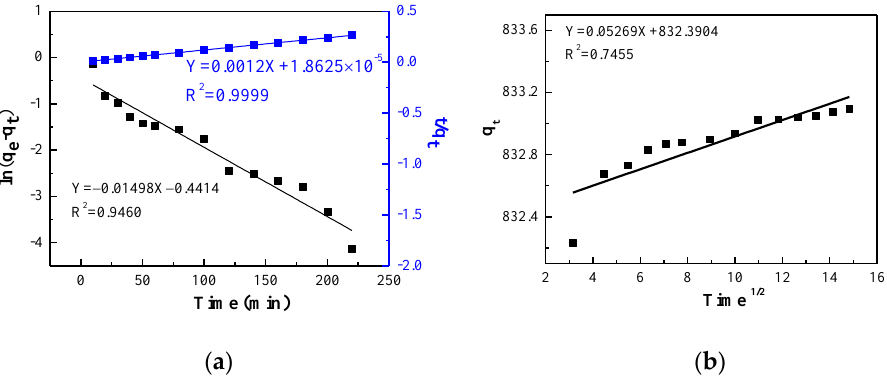
Figure 6. Fitting curve ( a ) Pseudo-first-order and pseudo-second-order kinetic. ( b ) Weber–Morris model.